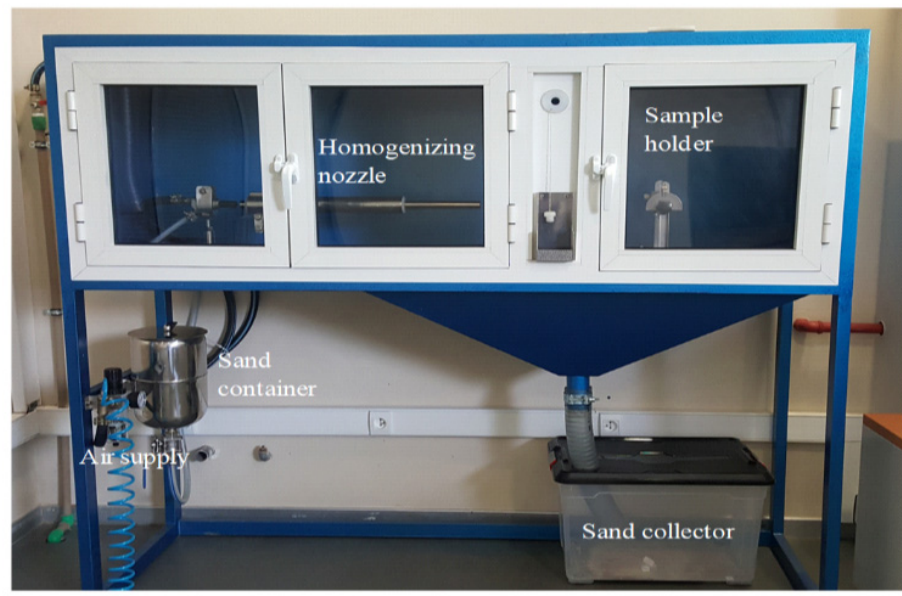
Figure 6. Erosion test bench developed at MAScIR’s laboratory.